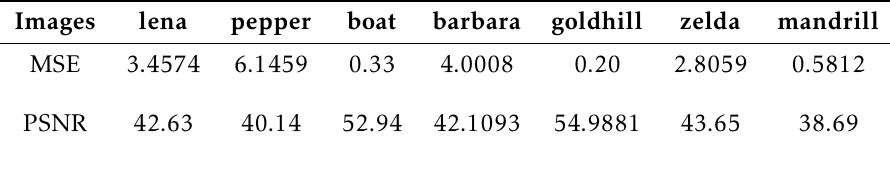
Figure 9: Stego images Table 1: Assessment of visual